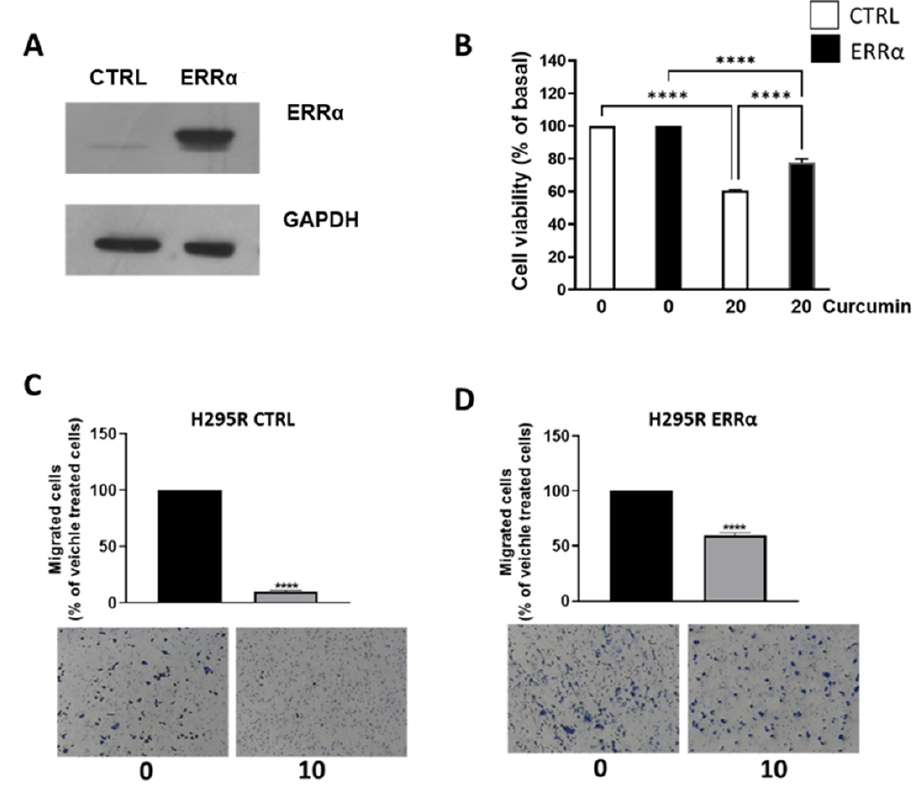
Figure 6. ERR α overexpression limits curcumin inhibitory effects on H295R cells. ( A ) ERR α protein expression was detected by Western blotting analysis in CTRL and ERR α overexpressing H295R cells. β Actin was used as a loading control. ( B ) H295R CTRL and ERR α cells were treated with the indicated doses of curcumin for 48 h. Cell viability was evaluated by MTT assay. The dose of 0 µ M curcumin (basal) was set as 100%. Results are expressed as mean ± SE of three independent experiments ( p < 0.0001). ( C , D ) H295R CTRL ( C ) and ERR α ( D ) cells, treated as indicated migrated through Boyden chambers for 18 h. Images of migrated cells were acquired (Magnification 20X). Bar graphs represent the mean ± SE of cell count from three independent experiments and setting 0 µ M as 100%. **** p <